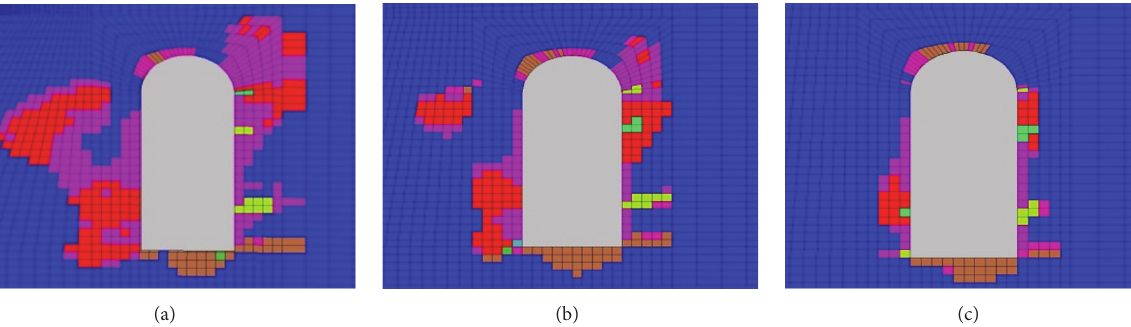
is equal to 1.5 have been numerically simulated. The